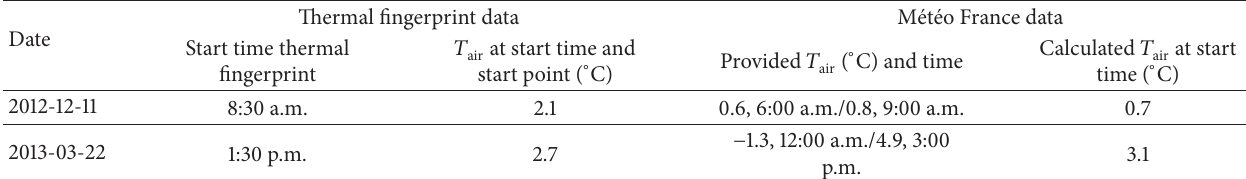
Table 4: 𝑇 data for RST forecast based on the coupling of PCA and PLS for RST forecast. air